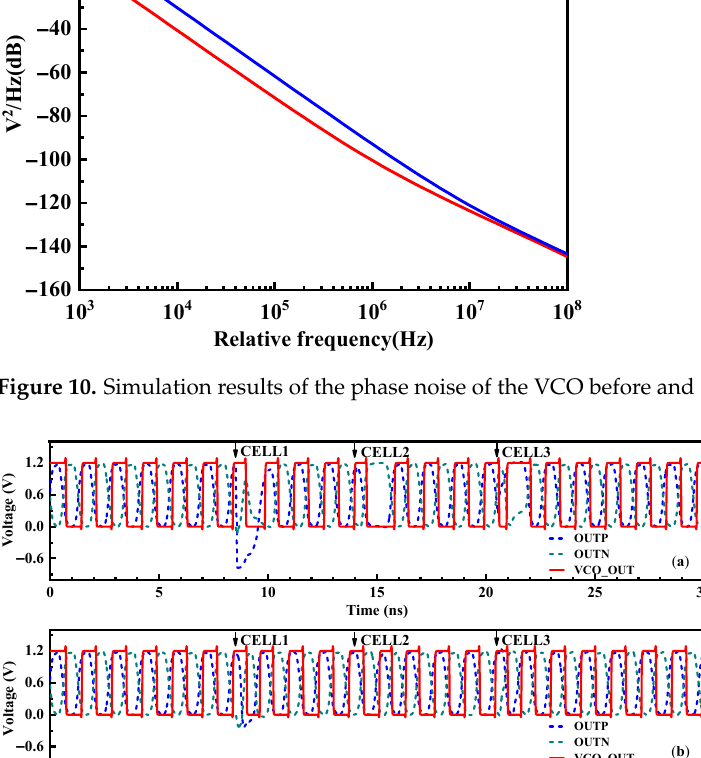
Figure 11. Simulation results of node voltage disturbance of the VCO delay cell. ( a ) Strike at node A. ( b ) Strike at node B.